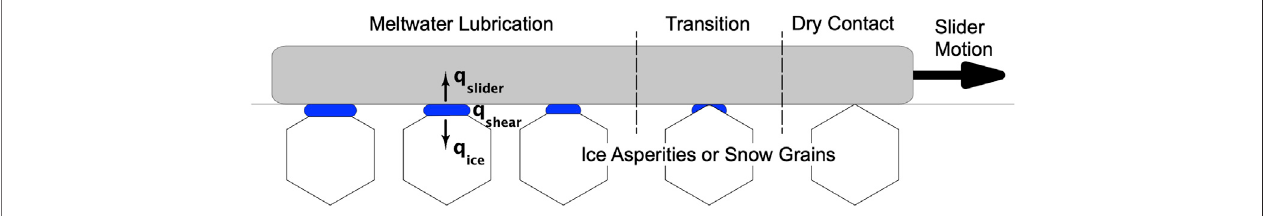
FIGURE 4 | Schematic of the self-lubrication hypothesis, which posits that low friction on ice and snow results from a lubricating water fi lm generated by frictional heat via shearing of that fi lm ( q f (cid:2) q shear , Eq. 5 ). Most self-lubrication formulations do not describe the mechanics of how dry contact at the front of a slider transitions to lubricated contact as sliding